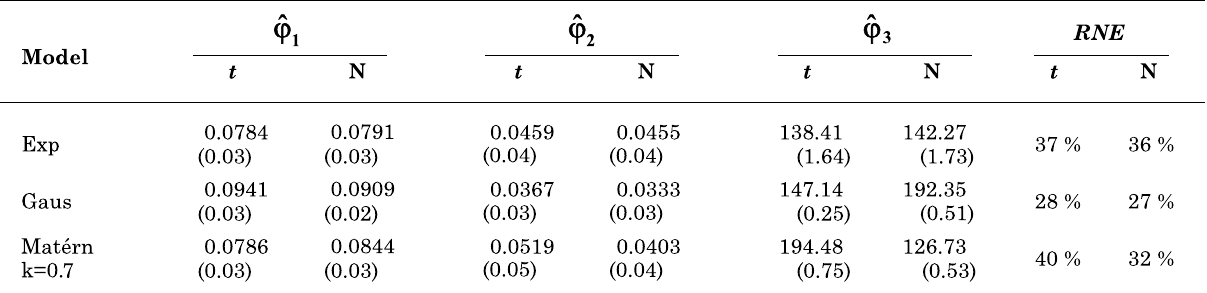
Table 2. Parameters estimated when adopting Student’s t -distribution with v = 3 and normal distribution for the yield variable